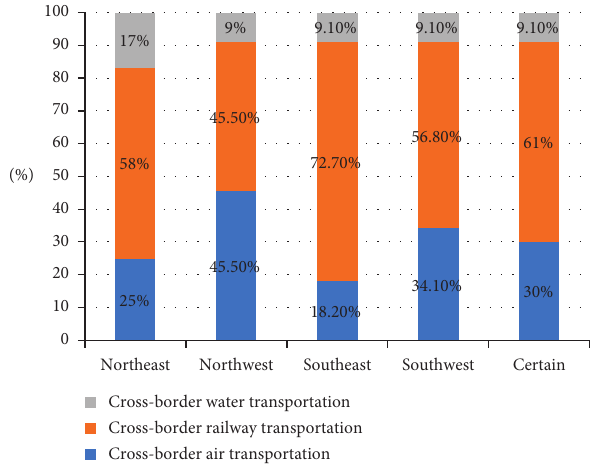
Figure 6: Proportion of transportation modes in optimal cross- border logistics